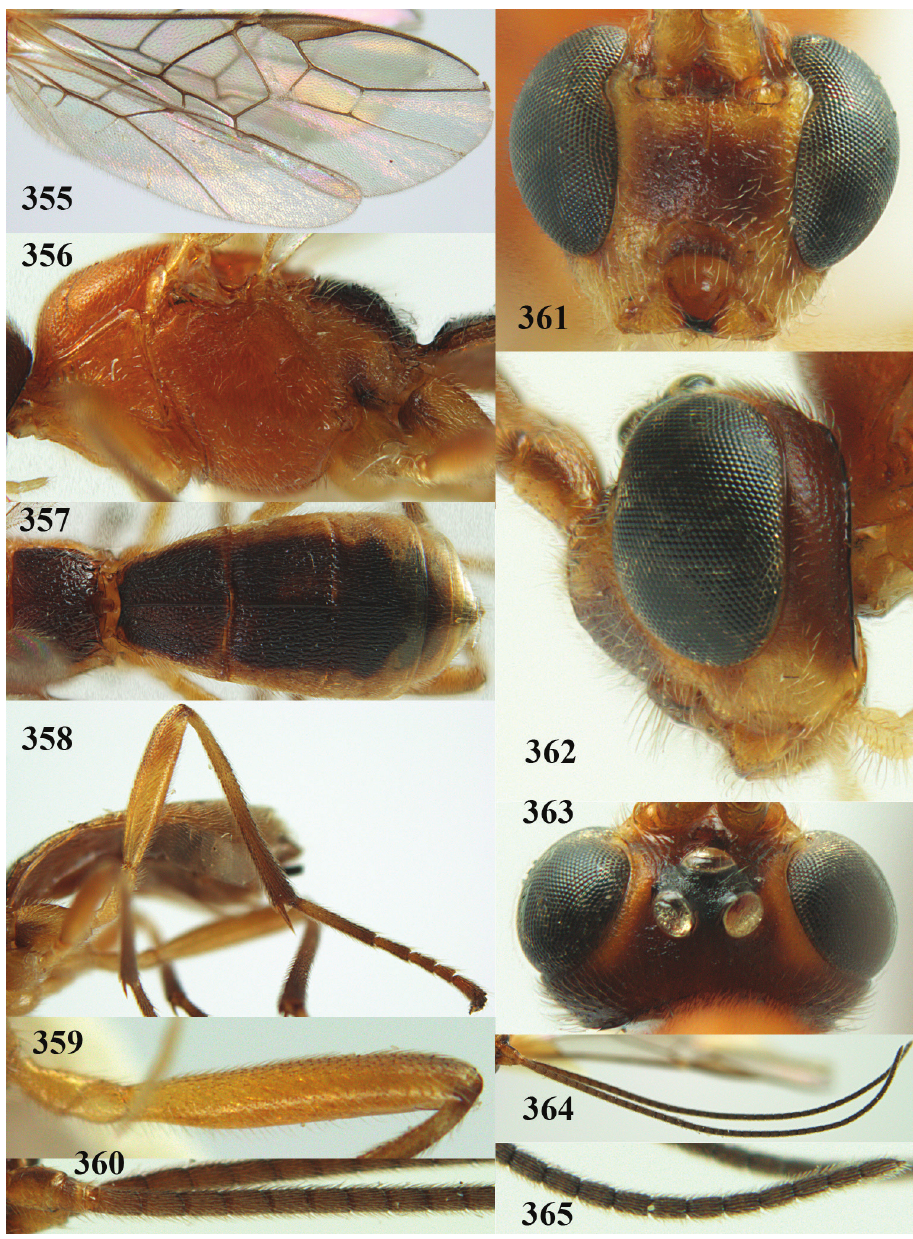
Figures 355–365. Aleiodes ungularis (Thomson), ♀ , France, Fayl Billot. 355 wings 356 mesosoma lateral 357 propodeum and metasoma dorsal 358 hind leg lateral 359 fore femur lateral 360 basal seg- ments of antenna 361 head anterior 362 head lateral 363 head dorsal 364 antenna 365 apical segments of